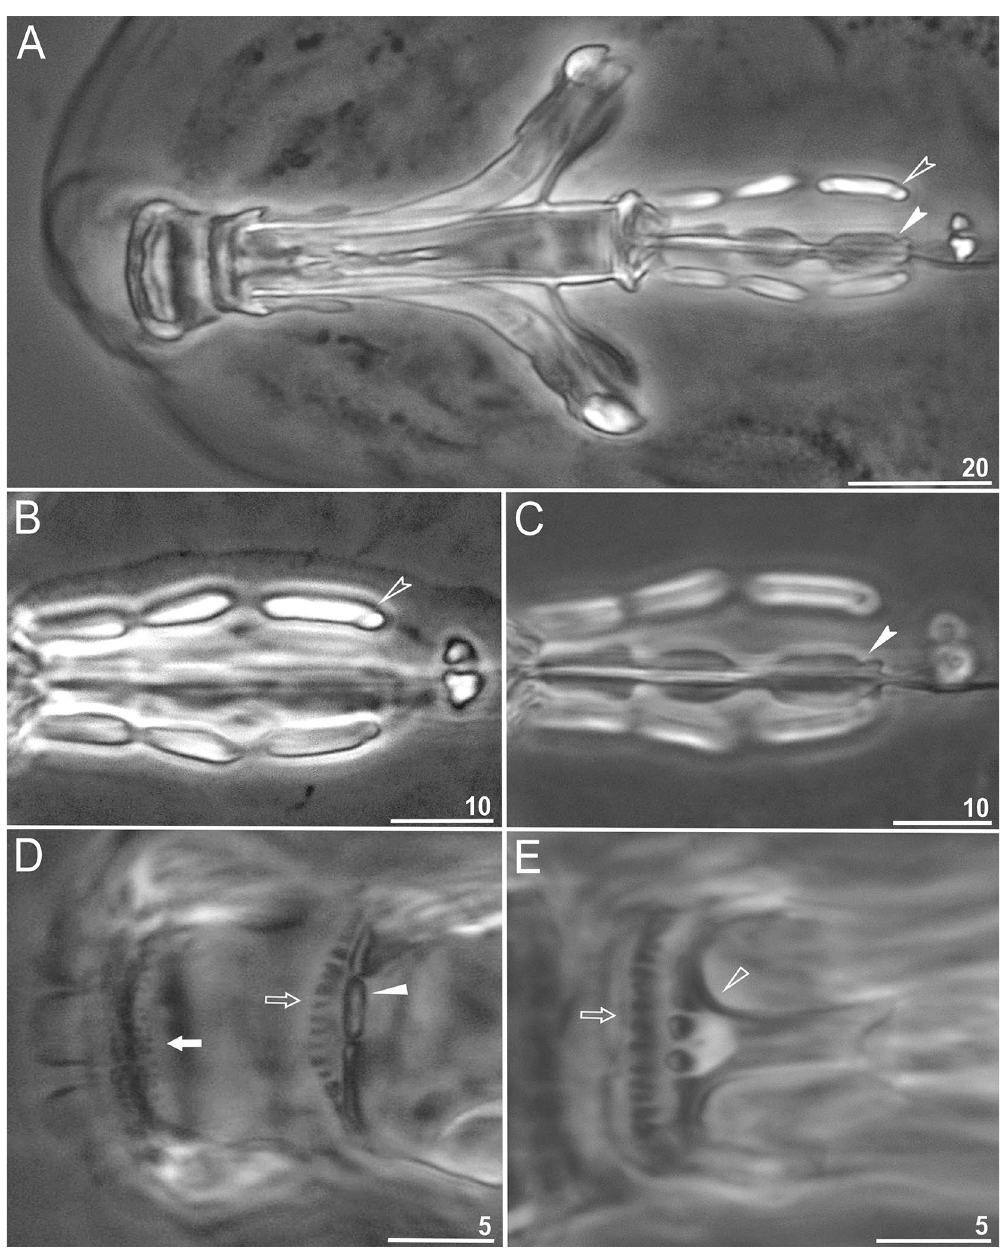
Figure 5. Paramacrobiotus gadabouti sp. nov.: ( A )—bucco-pharyngeal apparatus (dorso–ventral projection) general view (paratype); ( B )—placoid morphology in dorsal view (paratype); ( C )—ventral placoids (paratype); ( D )—oral cavity armature (paratype, PCM) seen from the dorsal side; ( E )—oral cavity armature (paratype, PCM) seen from the ventral side. Empty indented arrowhead represents third macroplacoid with sub-terminal constriction, filled indented arrowhead represents third macroplacoid with central constriction in ventral side, filled arrow represents first band of teeth, empty arrow represents second band of teeth, filled unindented arrowhead represents third band of teeth from dorsal side and empty unindented arrowhead represents third band of teeth from ventral side. Scale bars in